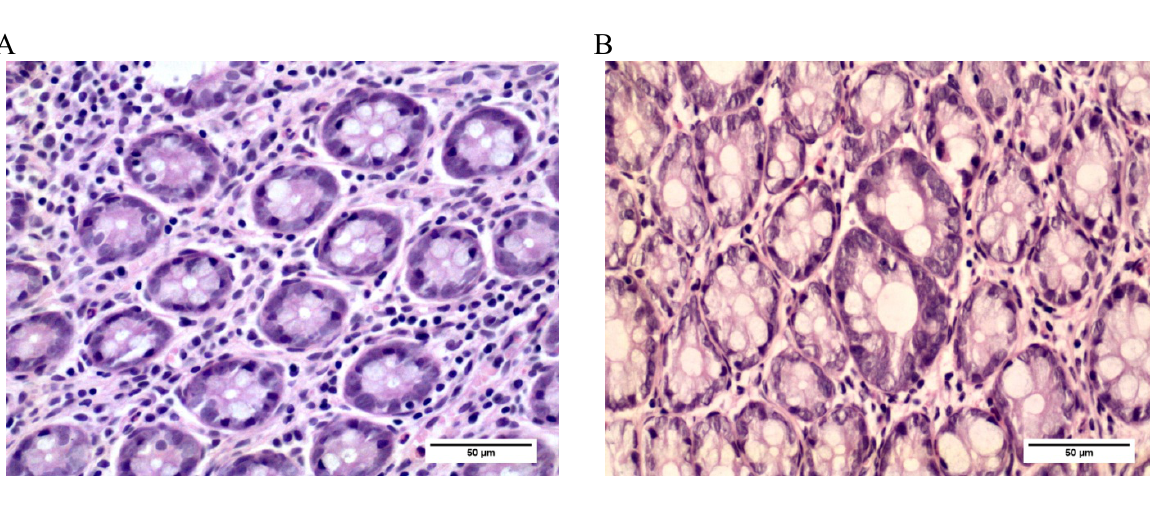
Figure 2. Photomicrography of rat colon tissue sections stained with H & E, ×400. ( A ) Photomicrography of normal colonic crypts. ( B ) Photomicrography of ACF in rats exposed to